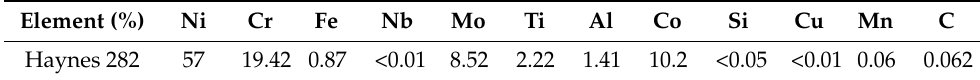
Table 2. Element percentages of the Haynes 282 [36].